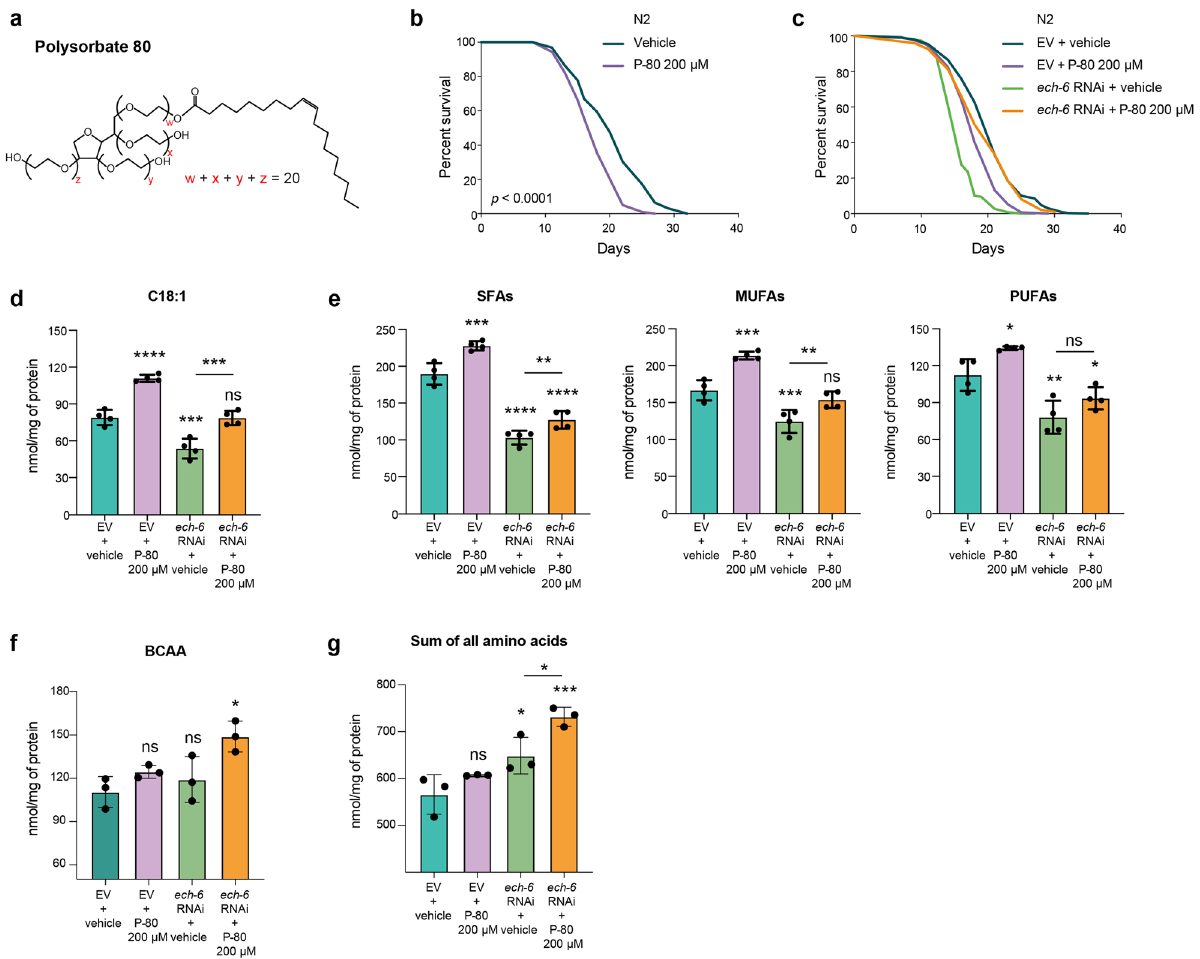
Figure 1. Knockdown of ech-6 antagonizes the effects of a fat diet on lifespan, oleic acid content and fatty acid saturation profile. ( a ) Chemical structure of polysorbate 80 (P-80). P-80 consists of a hydrophilic group of ethylene oxide polymers and oleic acid. ( b ) Survival curves of worms fed with 200 µM P-80 showing that worms live significantly shorter when subjected to a dietary excess of fat ( p < 0.0001, log-rank test). Vehicle: H 2 O, which applies to all the following figures. ( c ) Survival curves of worms treated with ech-6 RNAi or P-80 supplementation. Knockdown of ech-6 protects worms against P-80 diet-induced lifespan decrease ( p < 0.0001, log-rank test), while shortening lifespan under regular NGM dietary conditions ( p < 0.0001, log-rank test). ( d ) Mass spectrometry (MS) quantification of oleic acid in worms exposed to the P-80 diet. P-80 supplementation increases the level of oleic acid in empty vector-treated wild-type (N2) worms while compensates for the reduced level caused by reduction of ech-6 by RNAi. Mean ± SD of 4 biological replicates. ( e ) MS quantification of saturated fatty acids (SFAs), monounsaturated fatty acids (MUFAs), and poly unsaturated fatty acids (PFAs). Mean ± SD of 4 biological replicates. ( f ) UPLC-MS/MS quantification of branched-chain amino acids (BCAA). Knockdown of ech-6 in combination with P-80 supplementation significantly increases the level of BCAA. Mean ± SD of 3 biological replicates. ( g ) Quantification of total amino acids. Knockdown of ech-6 significantly increases the level of total amino acids. Mean ± SD of 3 biological replicates. * p < 0.05; ** p < 0.01; *** p < 0.001; **** p < 0.0001; ns, not significant; one-way ANOVA, Holm-Sidak correction. An asterisk directly above a box refers to statistical significance compared to empty vector (EV)-treated wild-type (N2) worms fed a regular NGM diet, while an asterisk over a line indicates statistical significance compared to inhibition of ech-6 by RNAi. See also Table S1 for lifespan